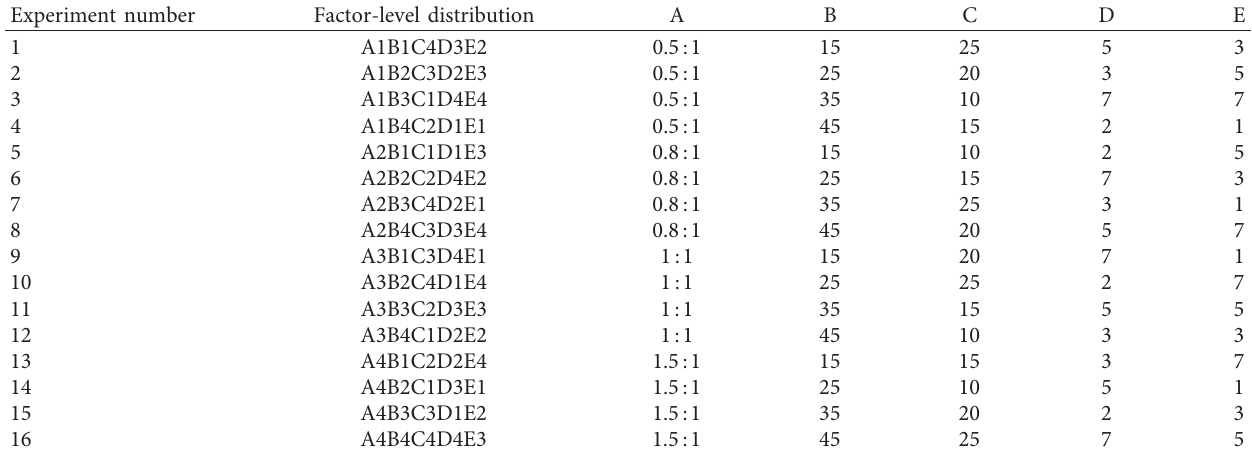
Table 6: Orthogonal experimental design.